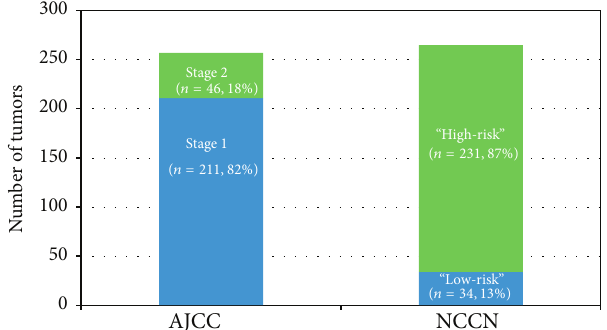
Figure 4: Proportions of “high-risk” and “low-risk” cSCCs by AJCC criteria versus NCCN